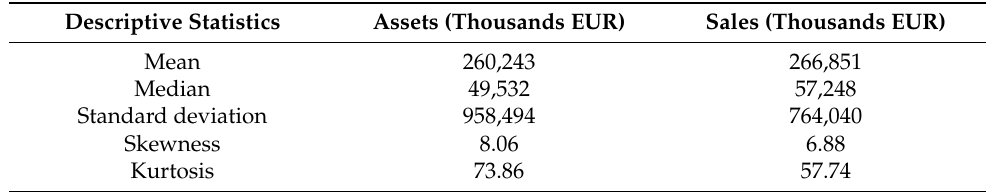
Table 1. Descriptive statistics of the